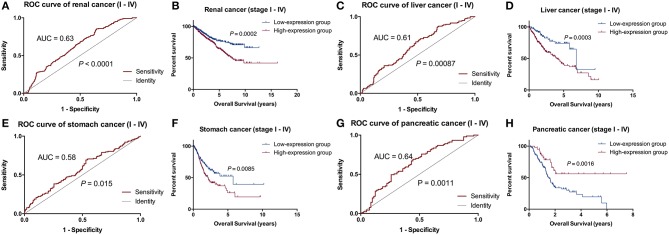
Kaplan-Meier analysis of the common tumors. In the ROC curve analysis, AUC of the patients with renal cancer was 0.63 (A), in liver cancer was 0.61 (C), in stomach cancer was 0.58 (E), and in pancreatic cancer was 0.64 (G). Kaplan-Meier curves indicated that the patients with renal cancer (B), liver cancer (D), and stomach cancer (F) in the RADIL high-expression group had poor OS, whereas patients in the low-expression group had positive outcomes; (H) pancreatic cancer patients with a high-expression of RADIL had a better OS.